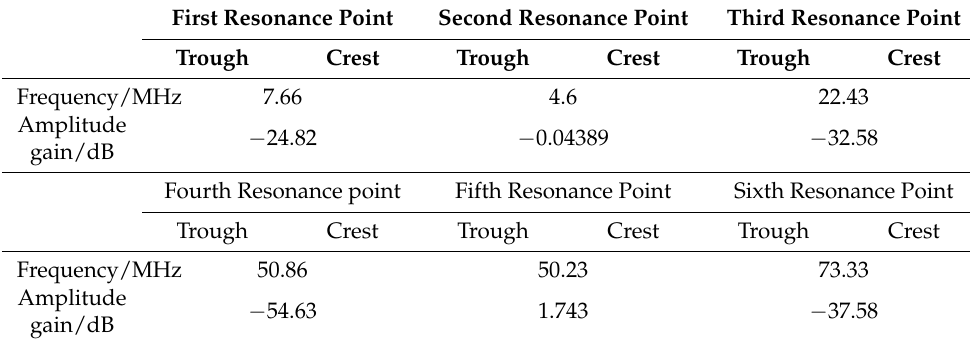
Figure 12. Frequency response curve of healthy winding. Table 11. Frequency and amplitude of resonance points of healthy winding.